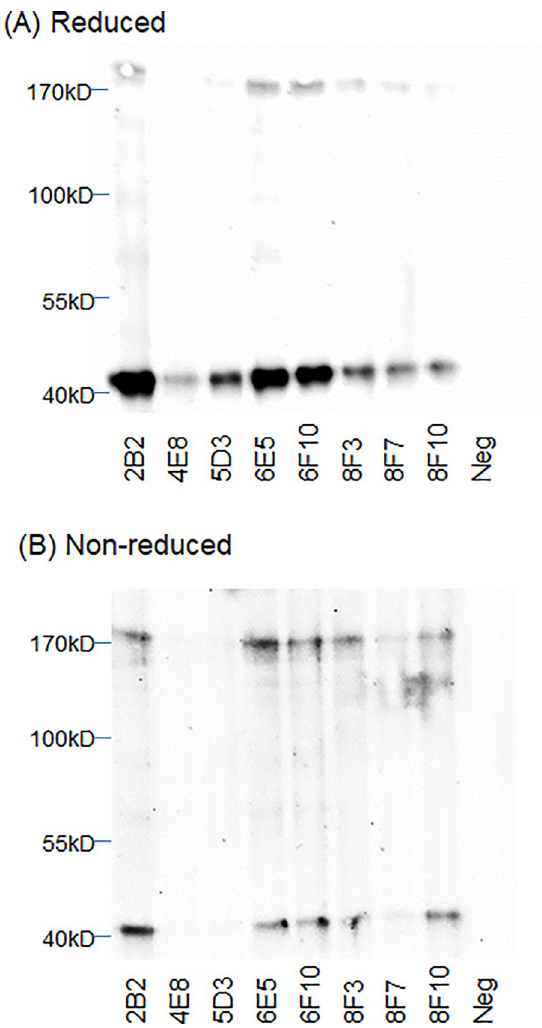
Fig 1. Western blot analysis of anti-LcrV monoclonal antibodies (mAbs) against Yersinia pestis Harbin-35 lysate. Horseradish peroxidase (HRP) conjugated LcrV mAbs (1 μ g/mL) were used to probe (A) reduced and (B) non- reduced Y . pestis Harbin-35 bacterial lysate (1.5x10 6 cells/lane) by direct Western